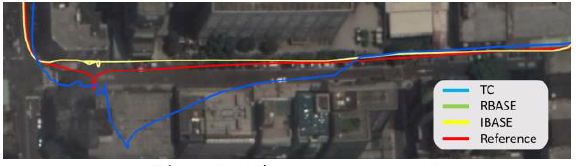
Figure 9. Urban canyon case - I